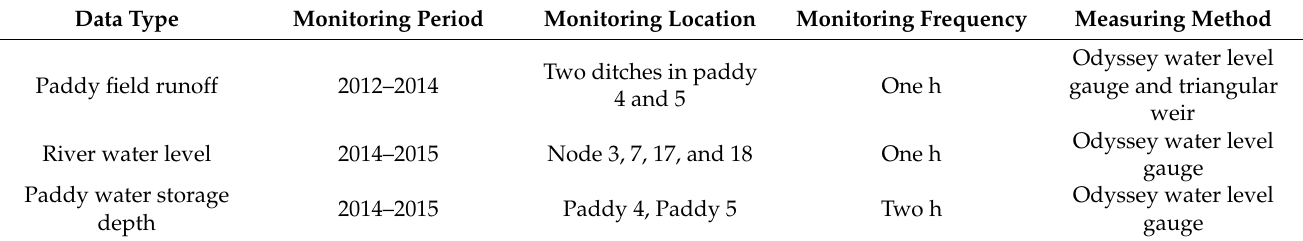
Table 3. Basic information for primary monitoring